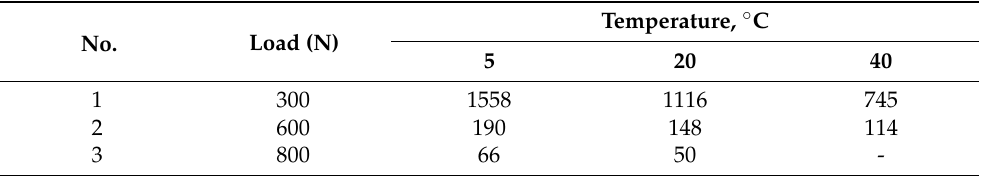
Table 1. The arithmetic mean (from 20 experiments) values of time (in sec) to destruction of the plates, depending on the load and temperature of the experiment